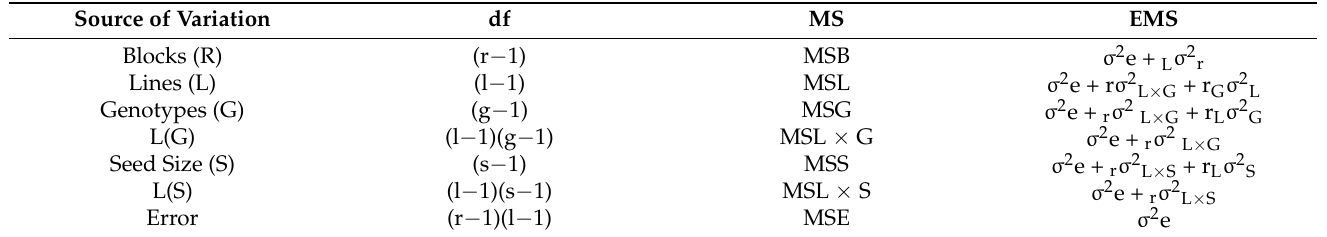
Table 3. Keys-out of the ANOVA table base on the genotypes and seed